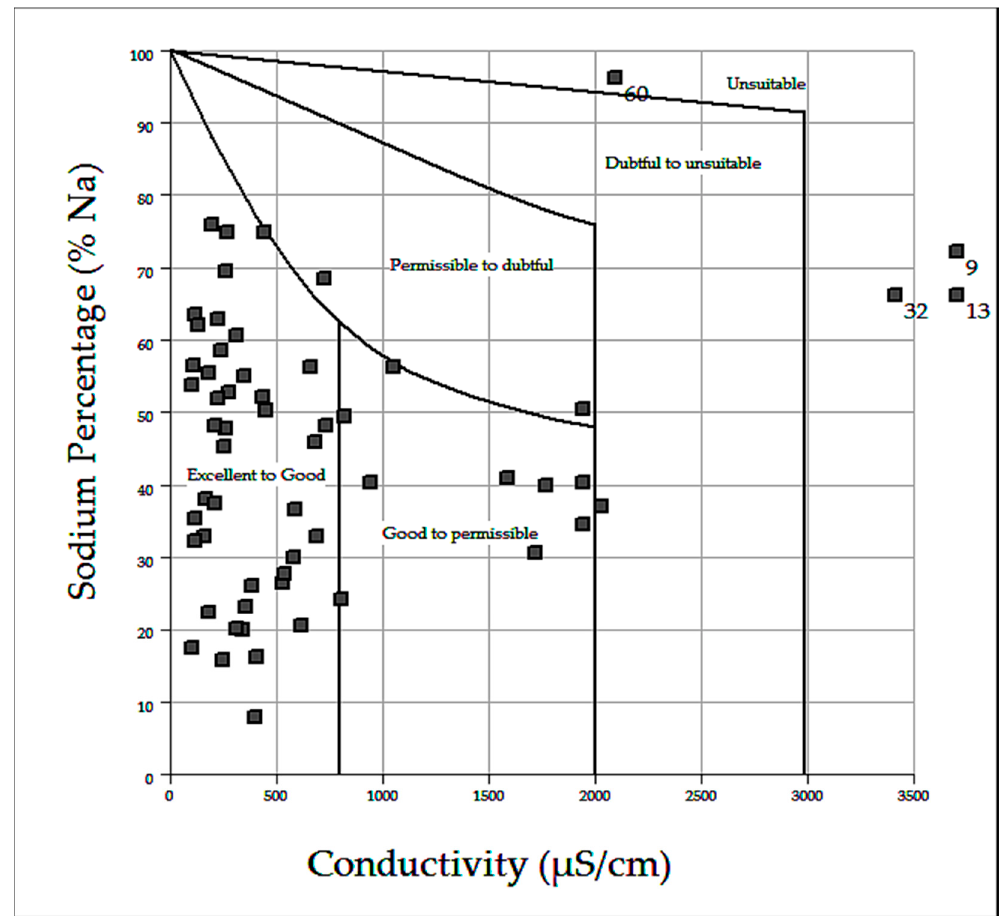
Figure 10. Suitability of groundwater for irrigation in Wilcox diagram. Table 8. Quality of groundwater based on residual sodium